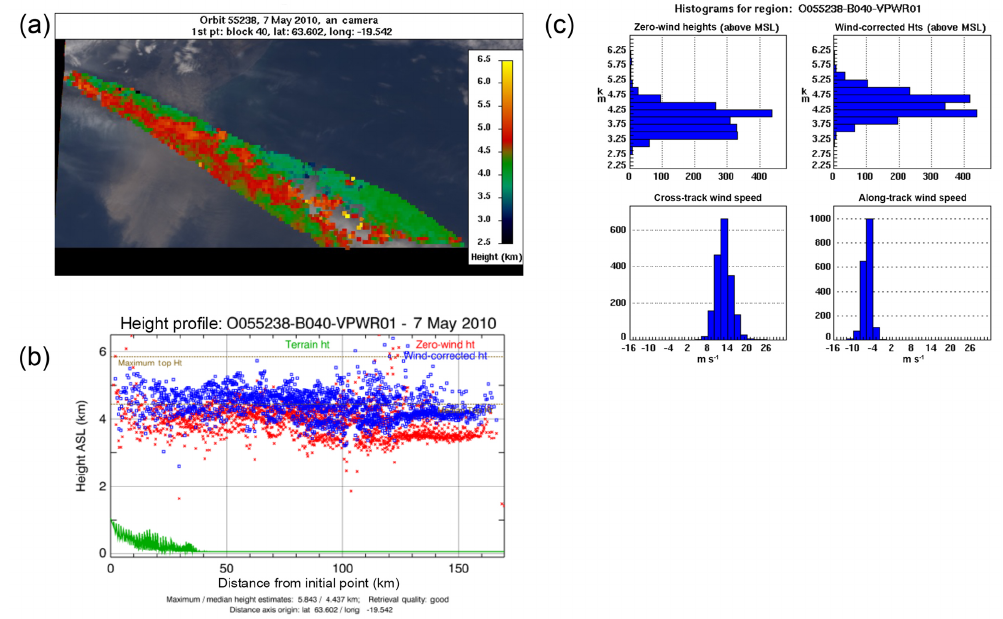
Figure 1. MINX height retrievals, measured from the geoid, for the Eyjafjallajökull volcano eruption plume, 7 May 2010. (a) Elevation map for the main plume. Each box represents a 0.55km area where the height is displayed with darker colors on the low end and warmer colors on the high end. (b) MINX height profile, as a function of distance from the source. Terrain elevation is indicated by the green line. The injection height is ∼ 5 . 8km directly above the source, and remains at similar elevation downwind. (c) MINX height histogram, provides distribution of height retrievals without a wind correction, with the wind correction, and the cross and along track wind